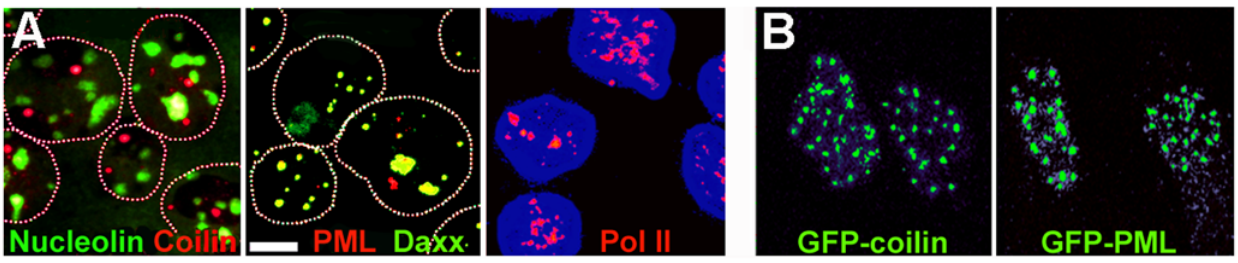
Figure 4. Compartments in nuclei isolated in 50% Ficoll, 100 m M K-Hepes by cell lysis with 0.5% Triton X-100 to permeabilise the nuclear membrane. (A) proteins characteristic of different compartments visualised by immunofluorescence as described in Figure 3. Daxx is a further component of PML bodies. (B) GFP-coilin or GFP-PML isoform IV fusion proteins in nuclei of HeLa or U2OS cells, respectively. In the two left panels, approximate nuclear outlines were traced from overexposed images. Images are maximum intensity projections from deconvoluted confocal